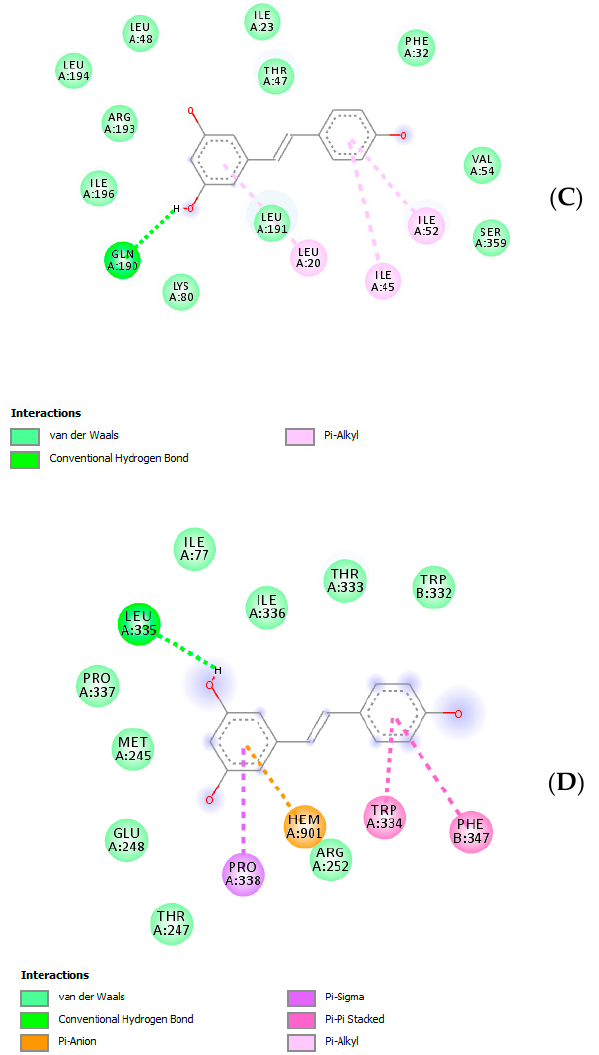
Figure 4. ( A ) Putative interactions between resveratrol and B. cereus superoxide dismutase A (SOD-A; PDB: 1XRE). Free energy of binding ( ∆ G) and a ffi nity (Ki) are − 7.0 kcal / mol and 7.5 µ M, respectively; ( B ) Putative interactions between resveratrol and B. cereus superoxide dismutase B (SOD-B; PDB: 3TQJ). Free energy of binding ( ∆ G) and a ffi nity (Ki) are − 7.2 kcal / mol and 5.4 µ M, respectively; ( C ) Putative interactions between resveratrol and B. cereus cytochrome P450 (CypD; PDB: 5JQV). Free energy of binding ( ∆ G) and a ffi nity (Ki) are − 7.4 kcal / mol and 3.8 µ M, respectively; ( D ) Putative interactions